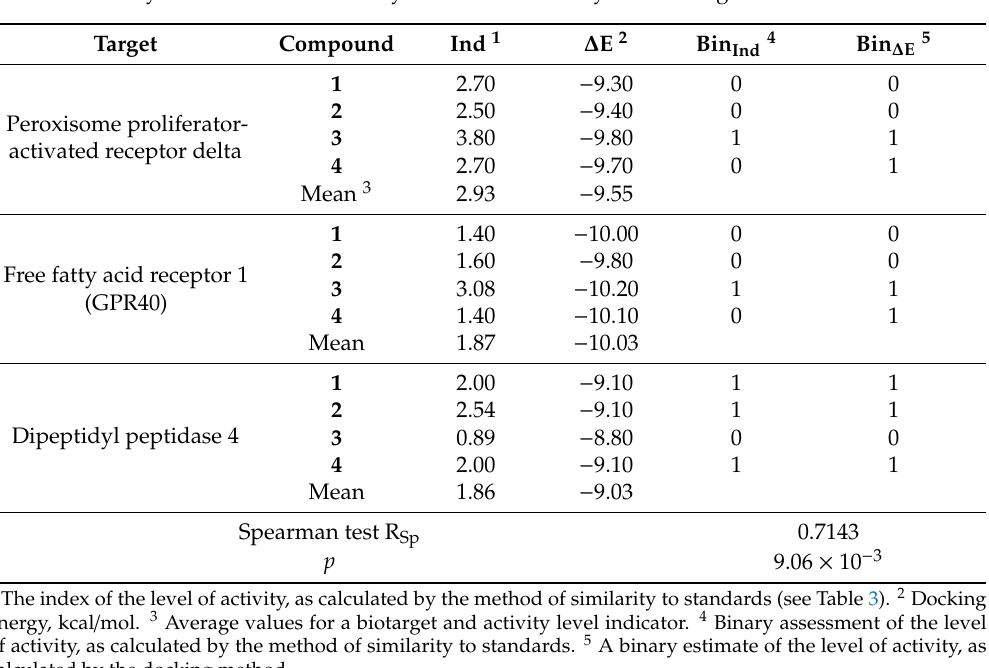
Table 4. A comparison of predictive estimates of the targeted activity of compounds 1–4 . The estimates were obtained by the method of similarity to standards and by the docking method.